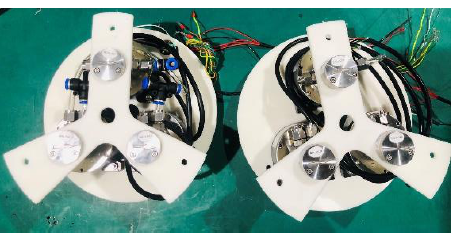
Figure A1. Physical diagram of micro water pump integrated system for underwater snake robot.